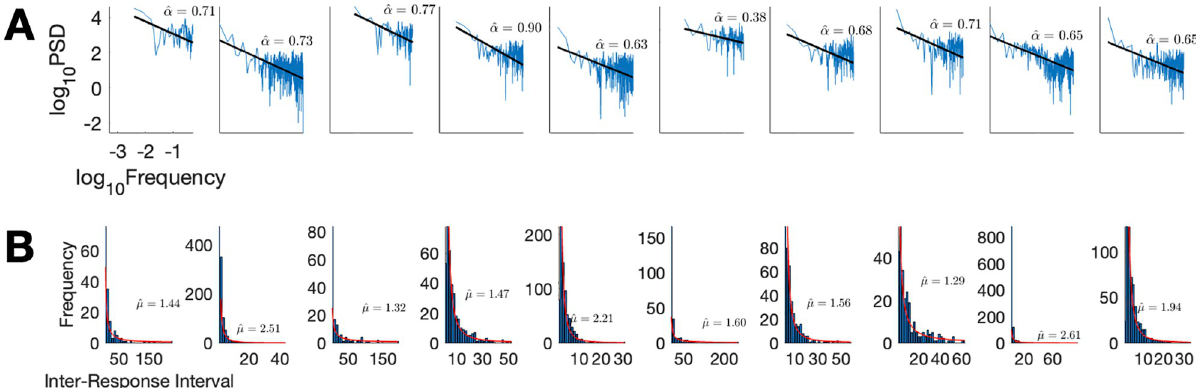
Fig 3. Individual data for the animal naming experiment. (A) Power spectral density. (B) Histograms of inter-response intervals. Fitted lines and curves are overlaid with exponents.